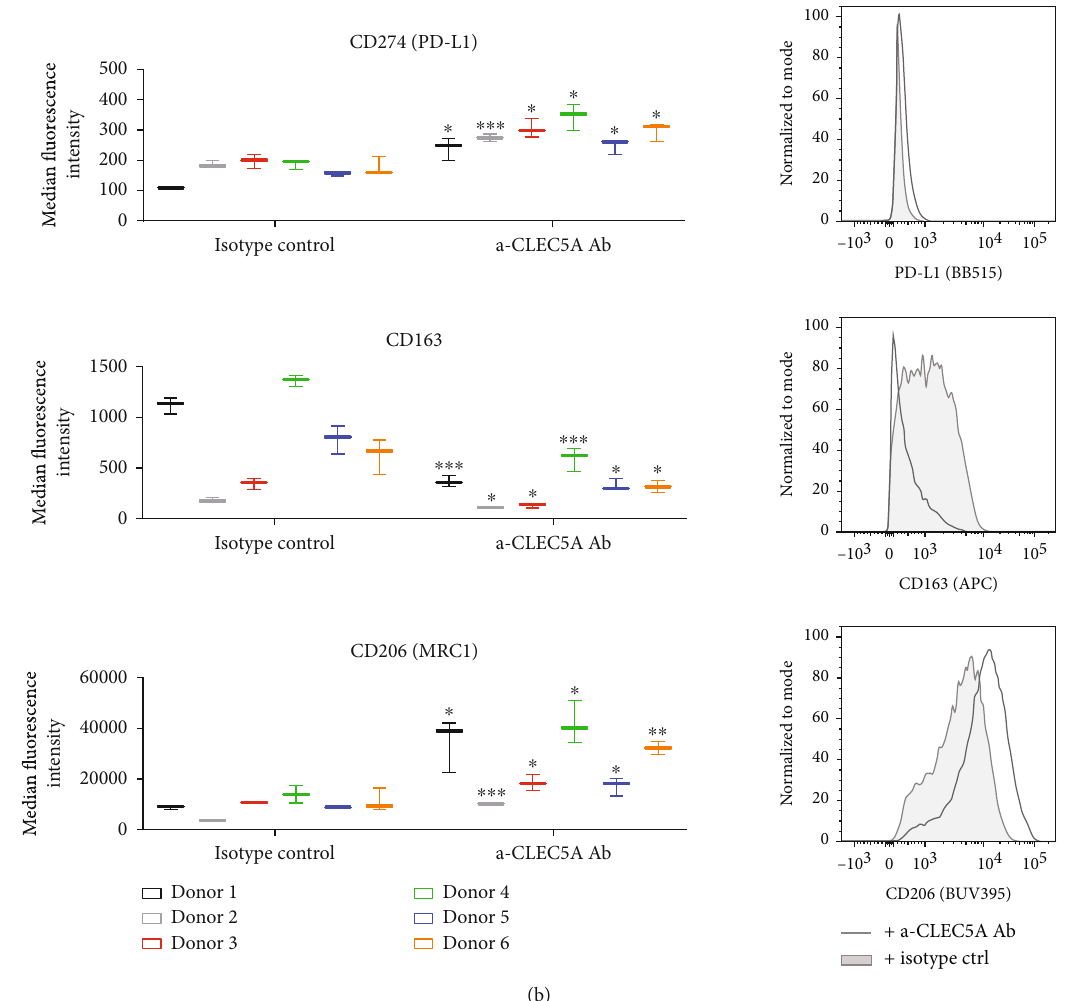
Figure 7: CLEC5A receptor agonist modulates the surface expression of other myeloid cell-speci fi c receptors. M0 MdM generated from same donors as in Figures 5 – 6 were incubated for 72 h on culture plates coated either with the α -CLEC5A Ab or with the isotype ctrl (10 μ g/mL) and then FACS stained with directly labelled monoclonal Abs against di ff erent membrane receptors. For FACS staining, monoclonal antibodies were diluted 1 :40 in 100 μ L FACS bu ff er. Graphs depict the expression of each marker shown as MFI for each donor tested, while histograms illustrate an exemplary FACS fl uorescence in one representative donor (grey line: MdM incubated with α - CLEC5A Ab; grey shadow: MdM incubated with isotype ctrl). Values represent the mean and SD from three technical replicates per each donor. Shown is the summary result from two independent experiments with n = 6 donors; ∗ p < 0 : 033 , ∗∗ p < 0 : 002 , and ∗∗∗ p < 0 : 001